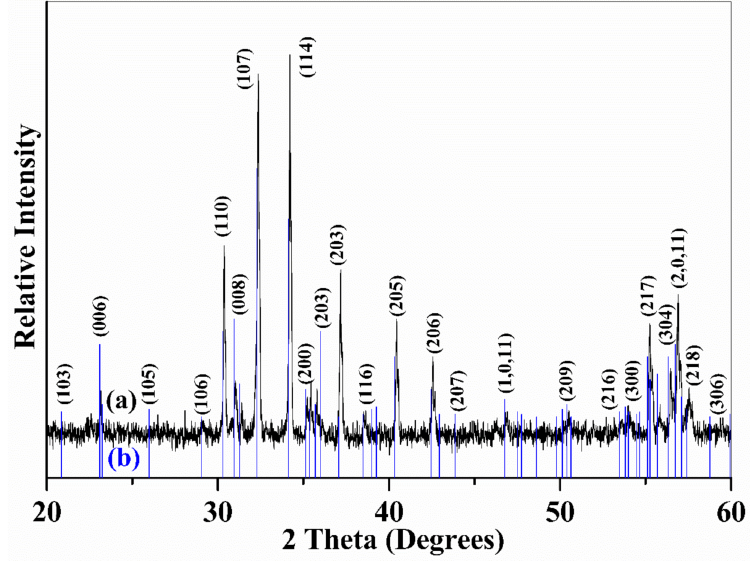
Figure 1. ( a ), XRD pattern of La 0.5 Sr 0.5 Fe 12 O 19 ceramic, which was sintered at 1350 ◦ C for 3 h; ( b ) the underneath discrete blue lines are standard diffraction spectrum of PbFe 12 O 19 (PDF# 41-1373).